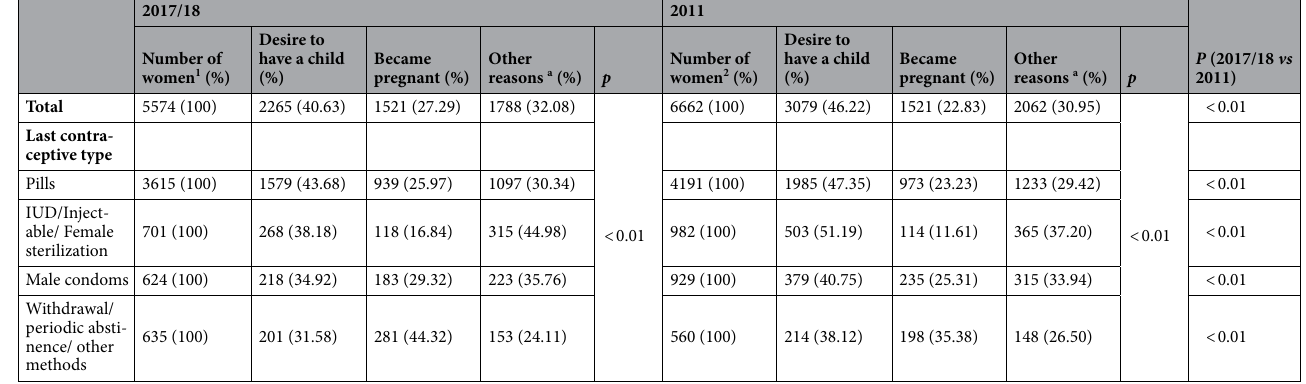
Table 2. Reasons for stopping the last pre-pregnancy contraceptives across methods type. 1 1651